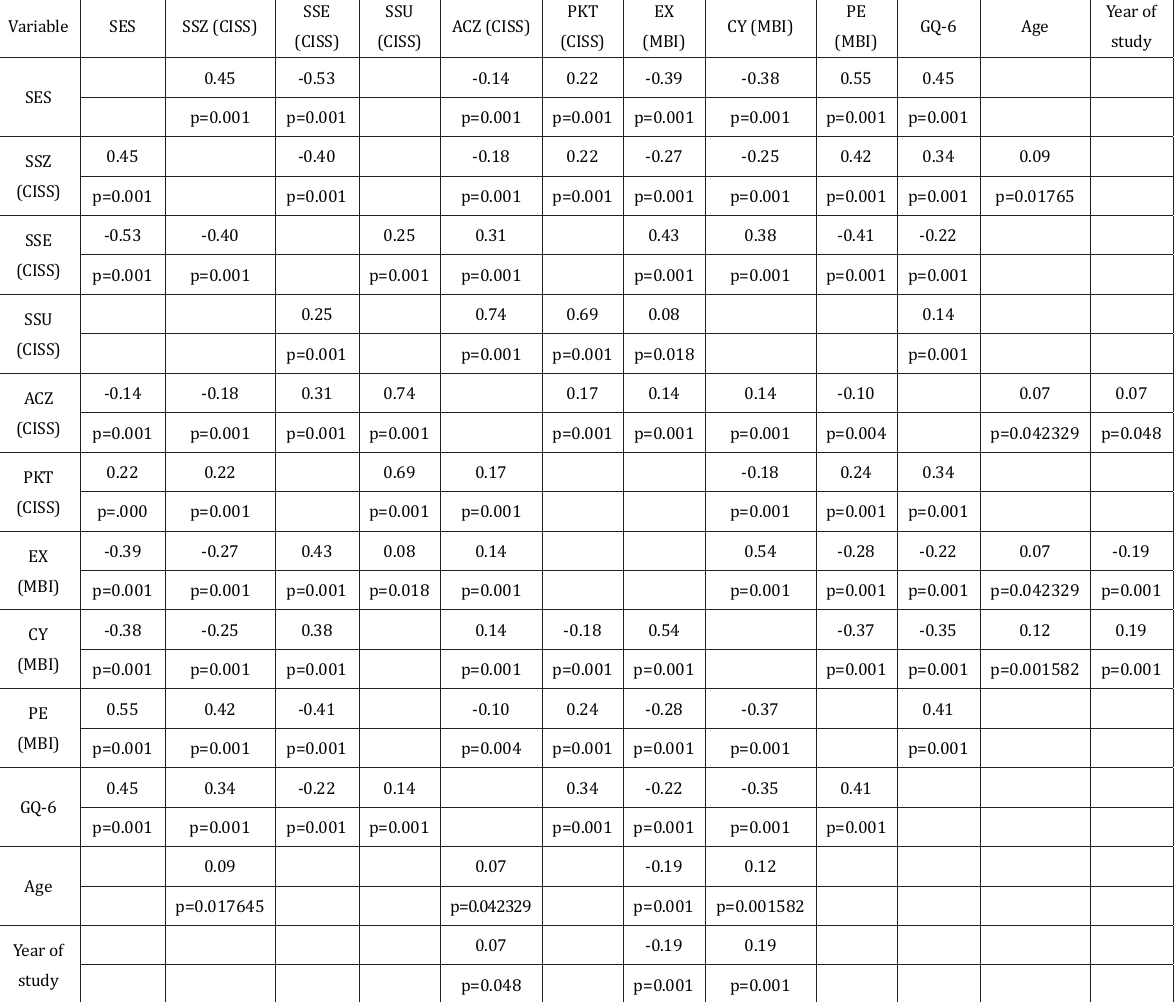
Table 6. The summary of the statistically significant correlation r values. Results which did not reach statistical significance were not included.